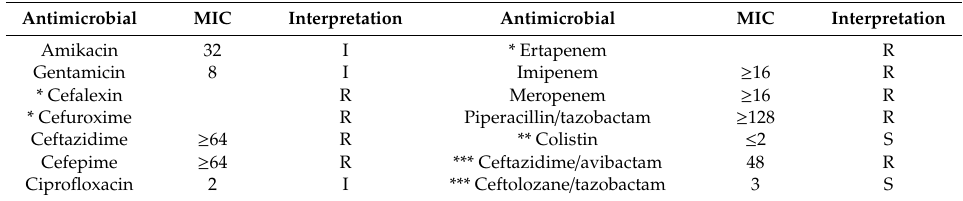
Table 1. Antimicrobial susceptibility results for multidrug-resistant Pseudomonas aeruginosa from bronchoalveolar lavage culture (Results are from VITEK ® 2 unless otherwise noted). Antimicrobial MIC Interpretation Antimicrobial MIC